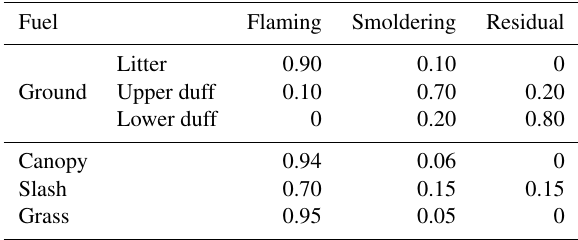
Table 2. Combustion-stage allocation factors for each fuel